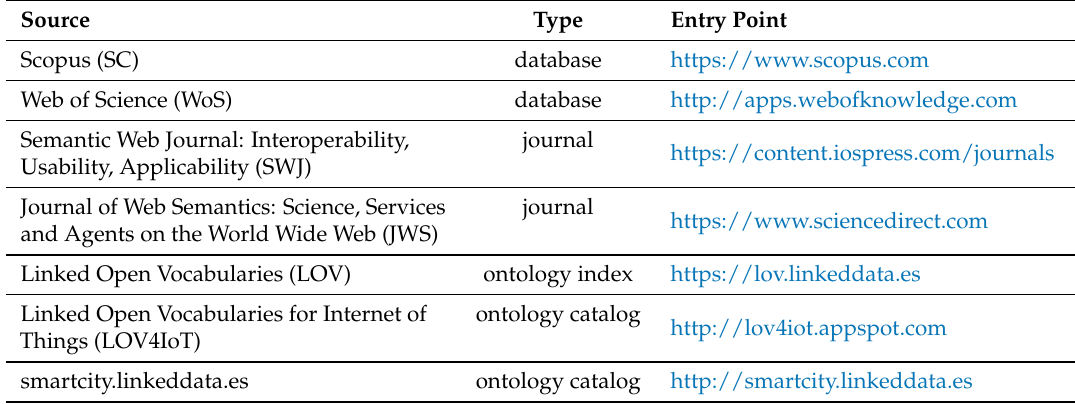
Table 1. Sources for the